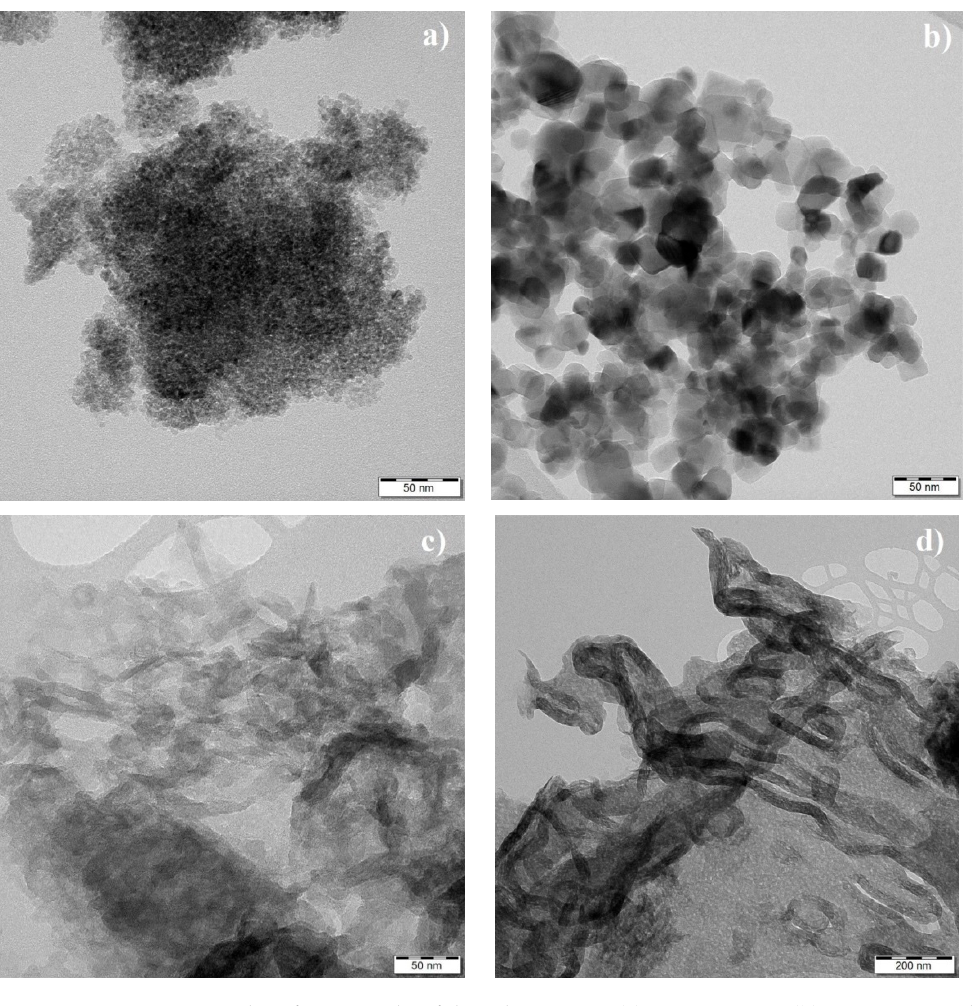
Figure 4. TEM micrographs of TiO 2 and exfoliated g-C 3 N 4 . ( a ) TiO 2 CG300, ( b ) TiO 2 P25, and ( c , d ) g-C 3 N 4